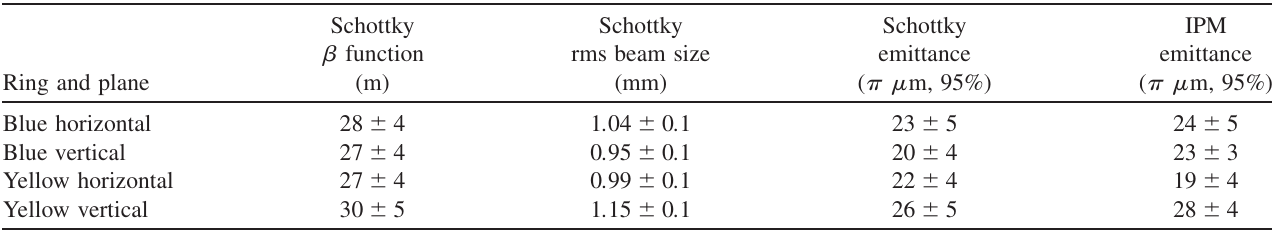
MEASURING TRANSVERSE BEAM EMITTANCE . . TABLE II. Results of Schottky emittance scan and comparison to RHIC IPM. Emittance values are normalized.